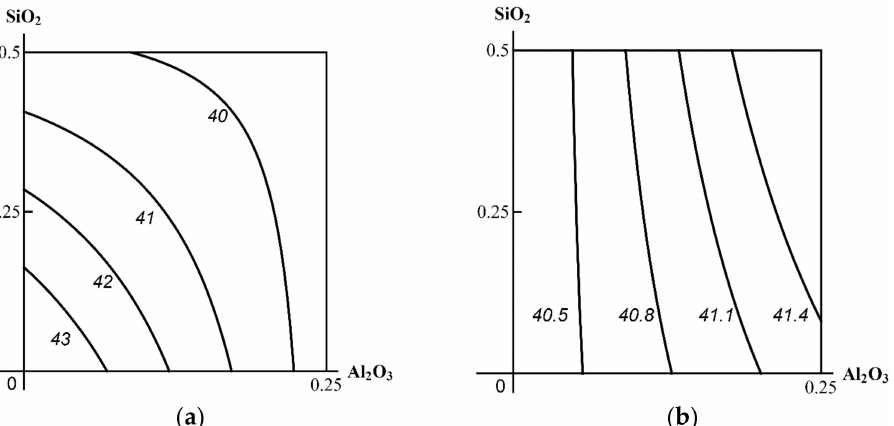
Figure 2. Examples of Class B three-factor toxicity: ( a ) unidirectional antagonism in the effect of SiO 2 + Al 2 O 3 nanoparticles on serum albumin changes in the absence of a third agent into ( b ) a single-factor effect of Al 2 O 3 alone in the presence of TiO 2 nanoparticles acting simultaneously in the background. MeO NP doses on the axes are plotted in mg per rat. Numbers on the isoboles show effect values ( µ